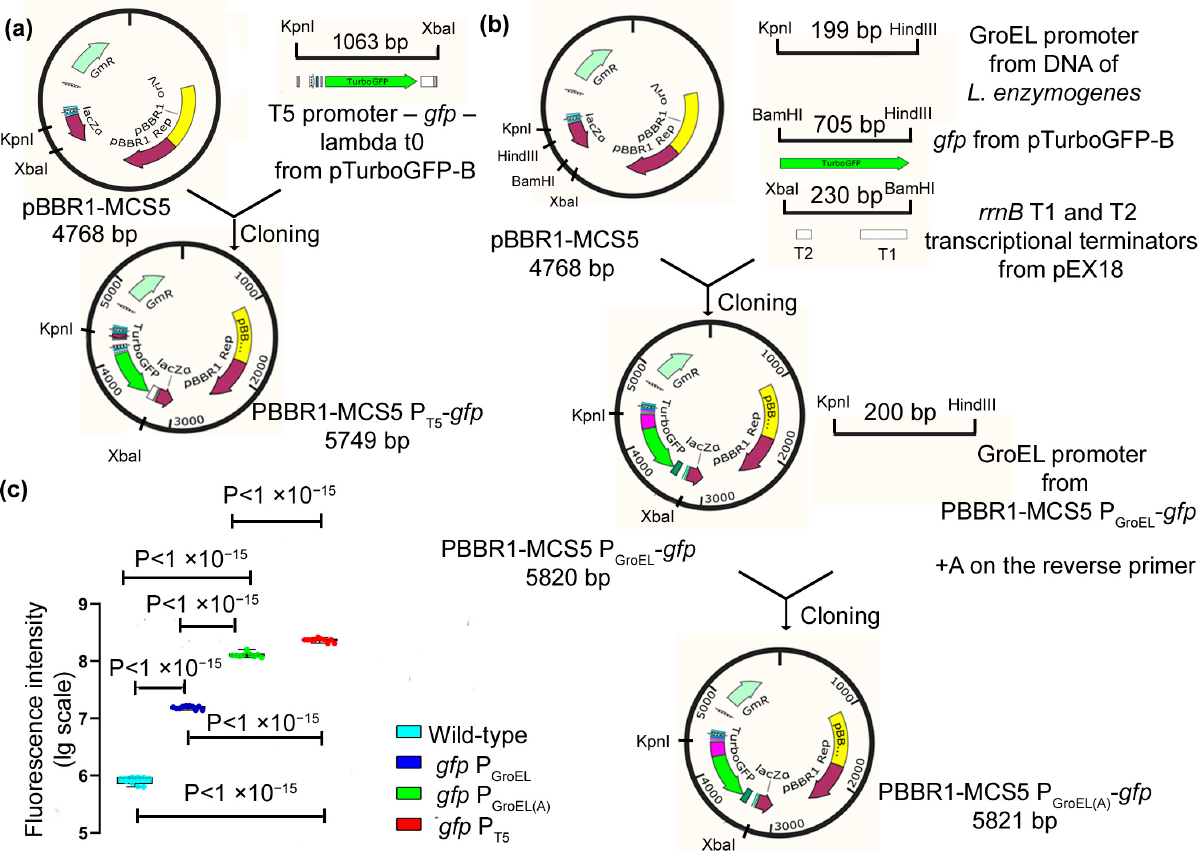
Figure 1. Construction of expression vectors PBBR1-MCS5 P GroEL - gfp , PBBR1-MCS5 P GroEL(A) - gfp , and PBBR1-MCS5 P T5 - gfp . ( a ) Scheme for constructing expression vector PBBR1-MCS5 P T5 - gfp . ( b ) Scheme for constructing expression vectors PBBR1-MCS5 P GroEL - gfp and PBBR1-MCS5 P GroEL(A) - gfp . ( c ) Measurement of fluorescence intensity in cells of L. capsici strains. The boxplots show the median and interquartile range (IQR). The values were obtained in three independent experiments: two independent experiments with two technical replicates and one independent experiment with six technical replicates. Statistical analysis was performed using a one-way ANOVA with Tukey’s multiple comparison test, p < 1 × 10 − 15 , F (3, 36) = 6712.